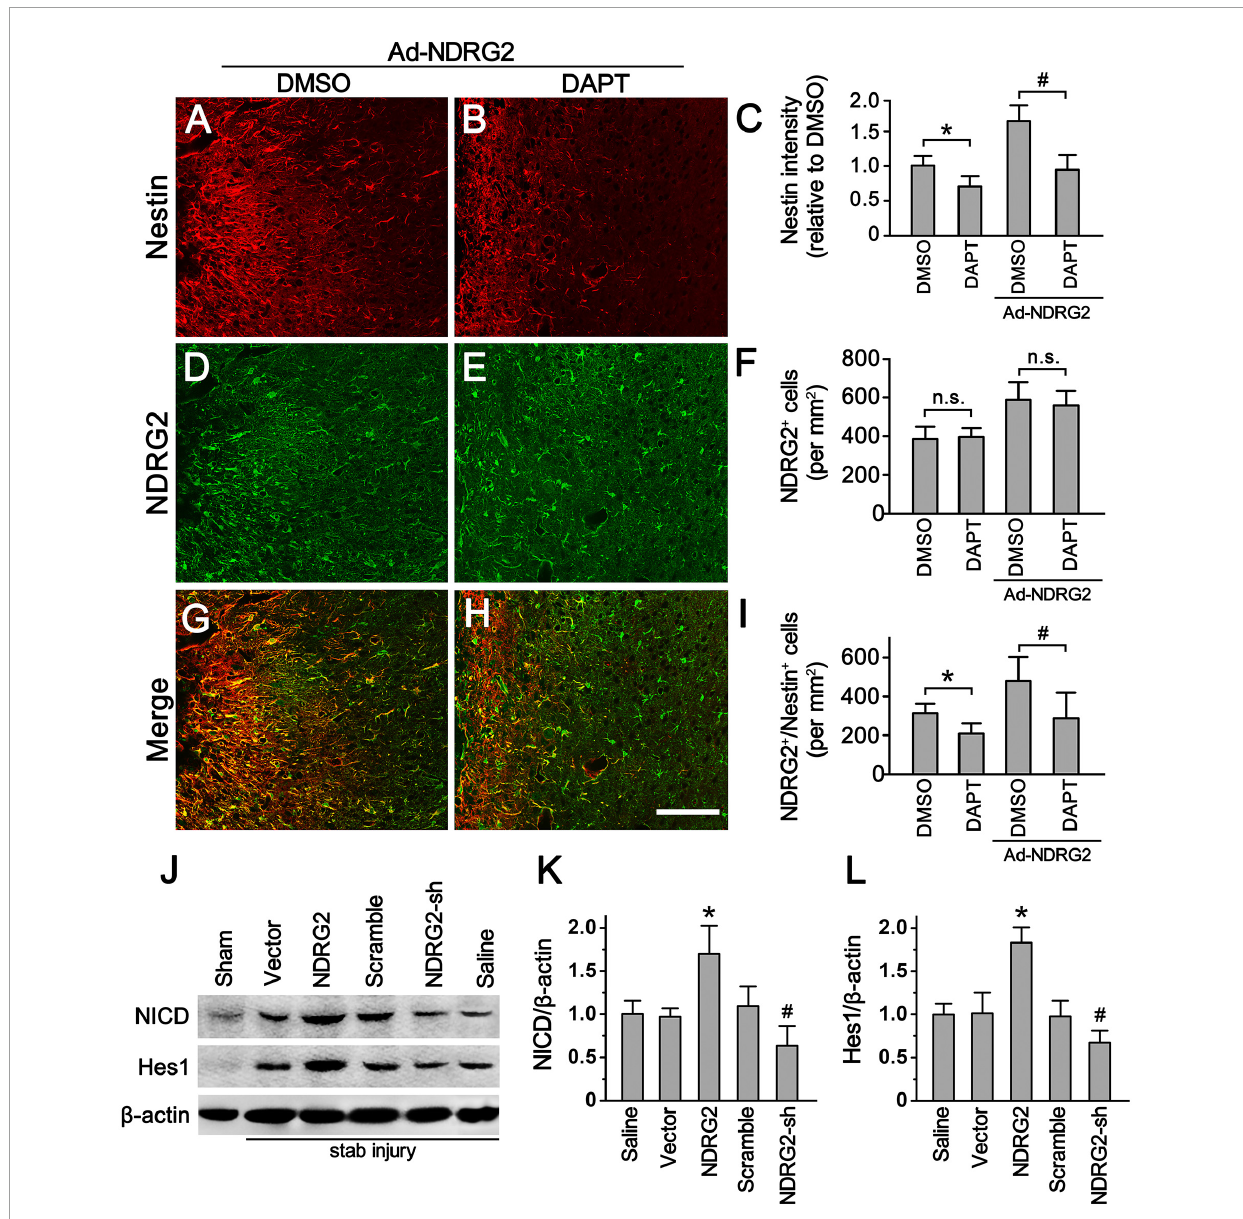
FIGURE4 Notch signal involves in NDRG2-regulated Rad-PCs. At the time when the stab-injured rats were received with or without recombinant adenoviruses encoding ndrg2 (Ad-NDRG2), they were treated with DAPT or DMSO intracerebroventricularly. (A–I) DAPT significantly decreased the immunoreactivity of Nestin (A–C) and the number of NDRG2 + /Nestin + cells (G–I) but did not affect the number of NDRG2 + cells (D–F) . Scale bar in panel (E) : 100 µ m. Data are shown as mean ± SEM ( n = 5). * p < 0.05, vs. the DMSO control. # p < 0.05, vs. the DMSO control treated with NDRG2-expressing adenoviruses. n.s., no significance. (J–L) Immunoblotting analysis showed that NDRG2 overexpression (NDRG2) upregulated the expression of NICD and Hes1 while knockdown of NDRG2 expression (NDRG2-sh) downregulated the expression of NICD and Hes1. In the